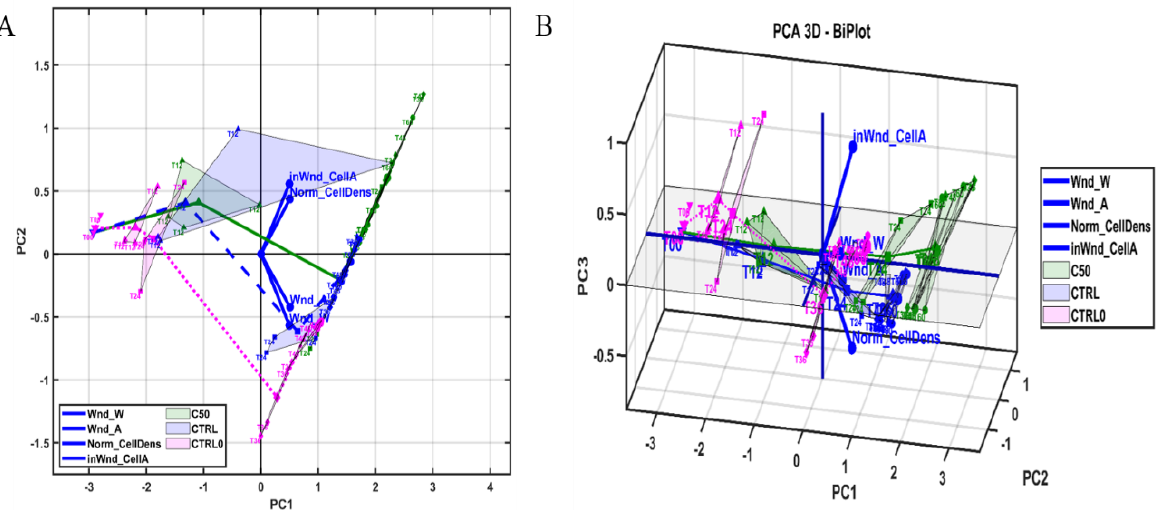
Figure 6. Biplots of PCA results: ( A ) 2D representation for PC1 and PC2 principal components; ( B ) 3D representation for PC1, PC2 and PC3 principal components. All sample values were involved in PCA calculus.